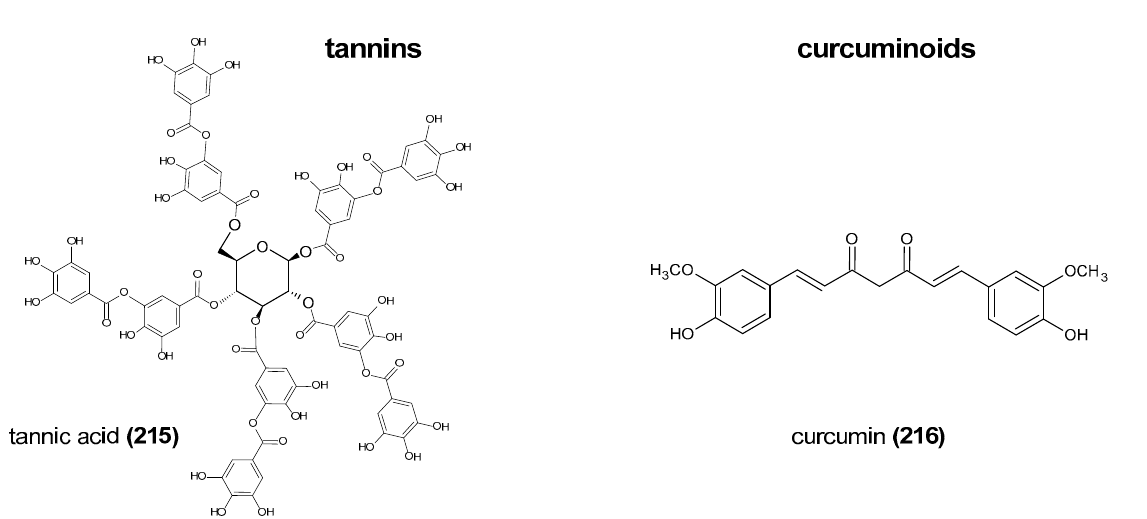
Figure 2. The chemical structure of various groups of non-flavonoid polyphenols. Based on [16,24,33–40].